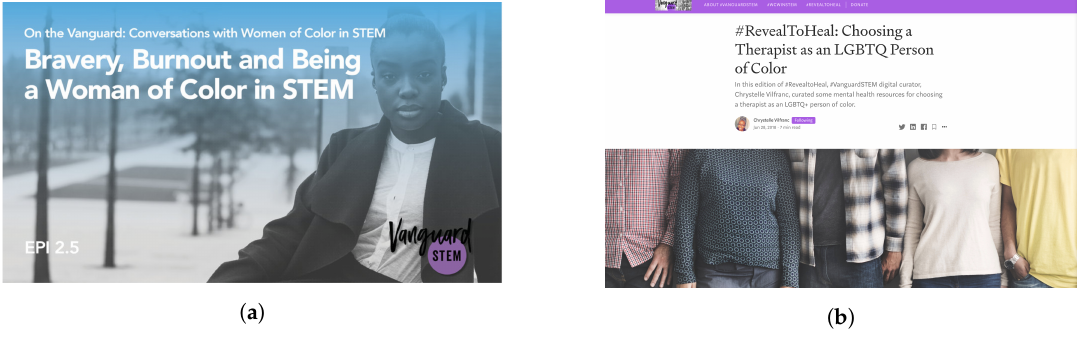
Figure 2. Artefacts from the #VanguardSTEM ( a ) live web series and ( b ) resource-driven curated digital content. Both examples make clear the standpoint of our materials and the audiences for whom they are intended. Anyone is welcome in our hyperspace, but we make clear that our hyperspace exists to center and highlight the experiences of women, girls and non-binary people of color in